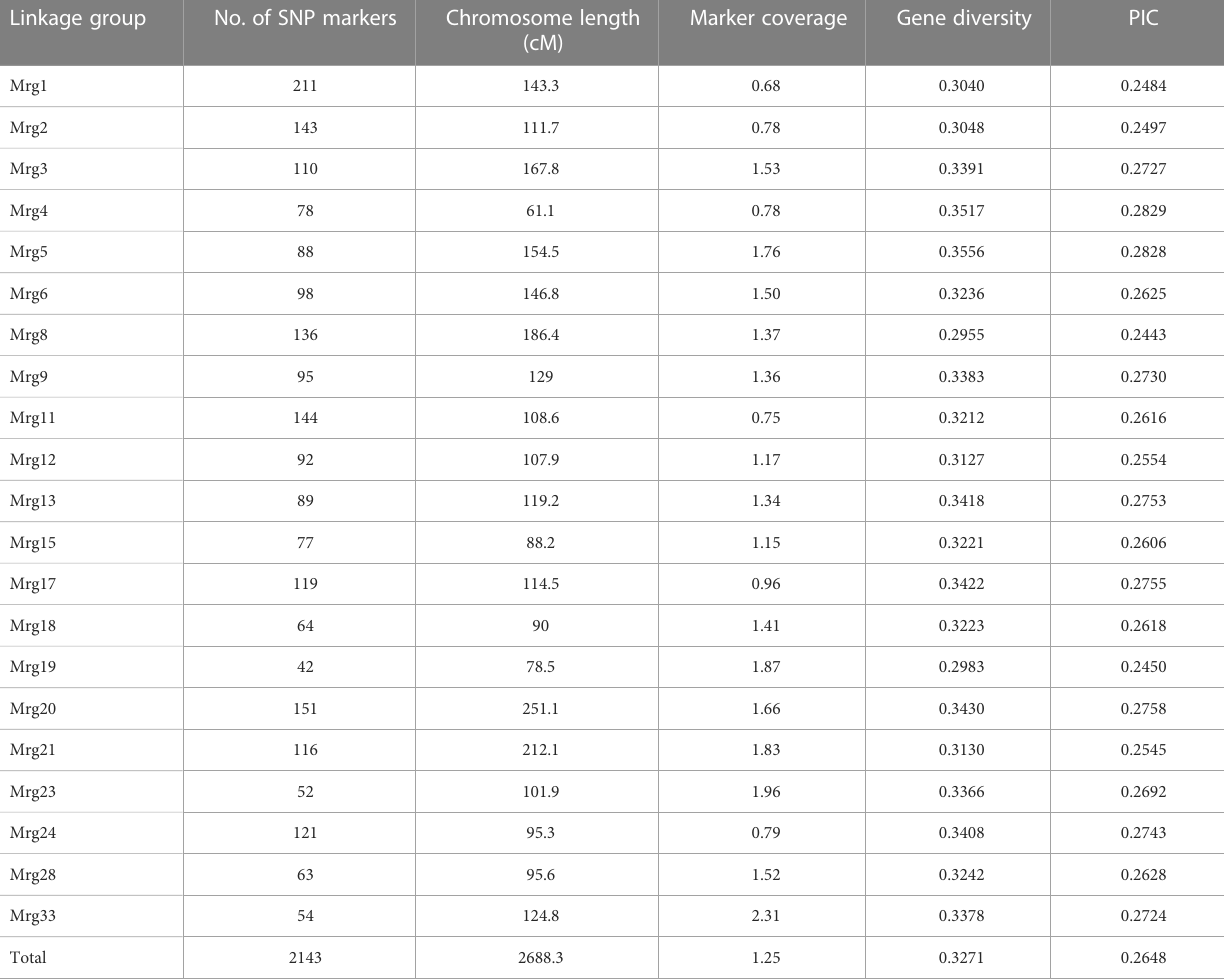
TABLE 1 SNP marker distribution and coverage, gene diversity, and polymorphic information content (PIC) across all linkage groups in 288 oat accessions. Linkage group No. of SNP markers Chromosome length Marker coverage Gene (cM)